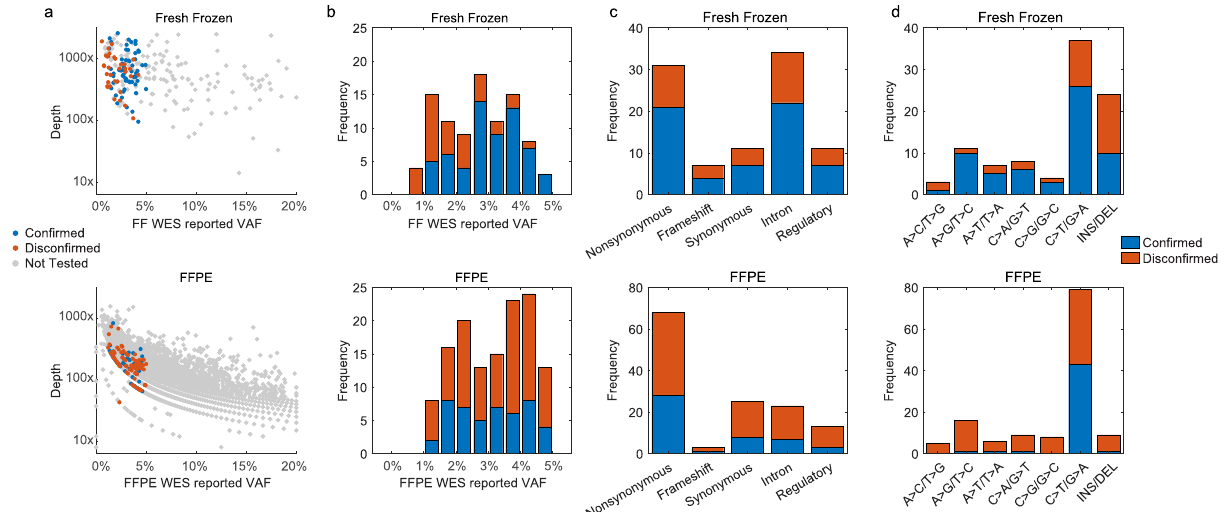
Figure 3. Characterization of WES variant confirmation. ( a ) The confirmation profile was determined by plotting the WES depths against the VAFs. We tested 94 variants called from the fresh-frozen sample and 132 variants called from the FFPE sample by BDA qPCR/Sanger analysis. Variants were either confirmed (blue) or disconfirmed (red). Variants called in WES but not tested by BDA are shown in grey. ( b ) BDA confirmation results by VAF distribution. ( c ) BDA confirmation results by variant functional categories. ( d ) BDA confirmation results by alteration types.